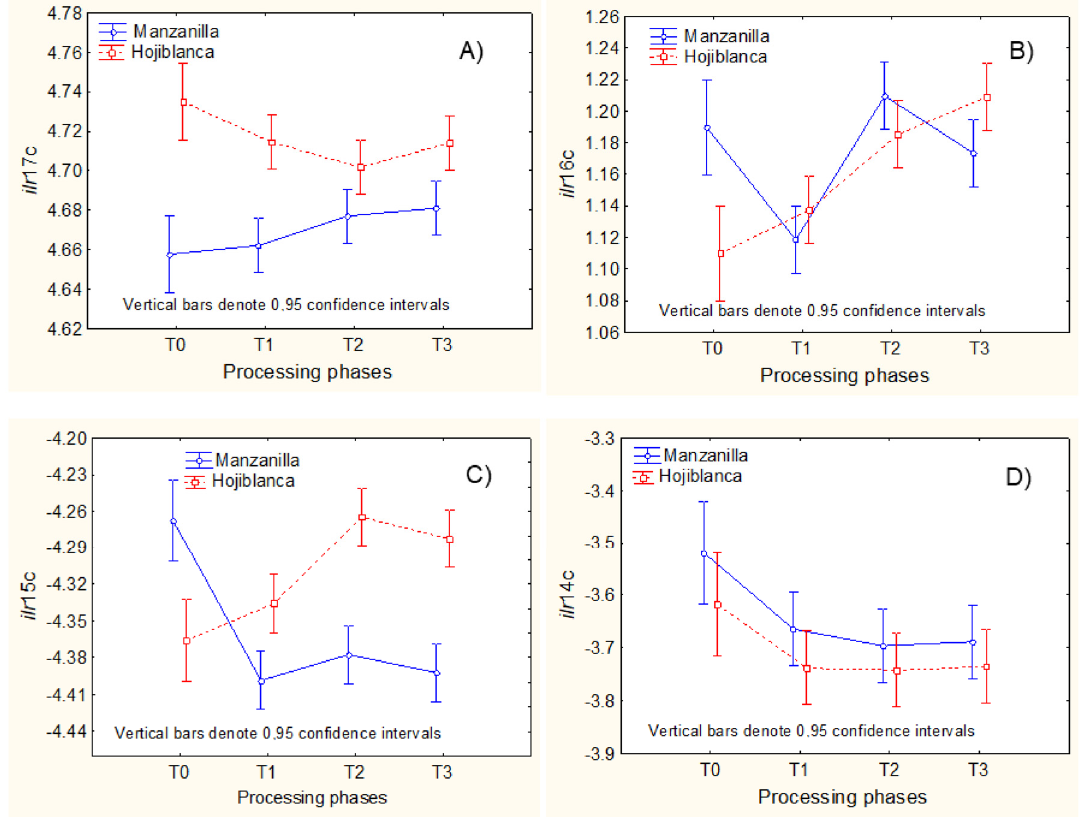
Figure 7. Examples of the influence of processing phases on ilr coordinates deduced from SBP following Ward’s clustering (“c” after the ilr coordinate number). ( A – D ) show ilr coordinates which showed significant differences between cultivars. T0, fresh olives; T1, lye-treated olives; T2, fermented olives; T3, packaged